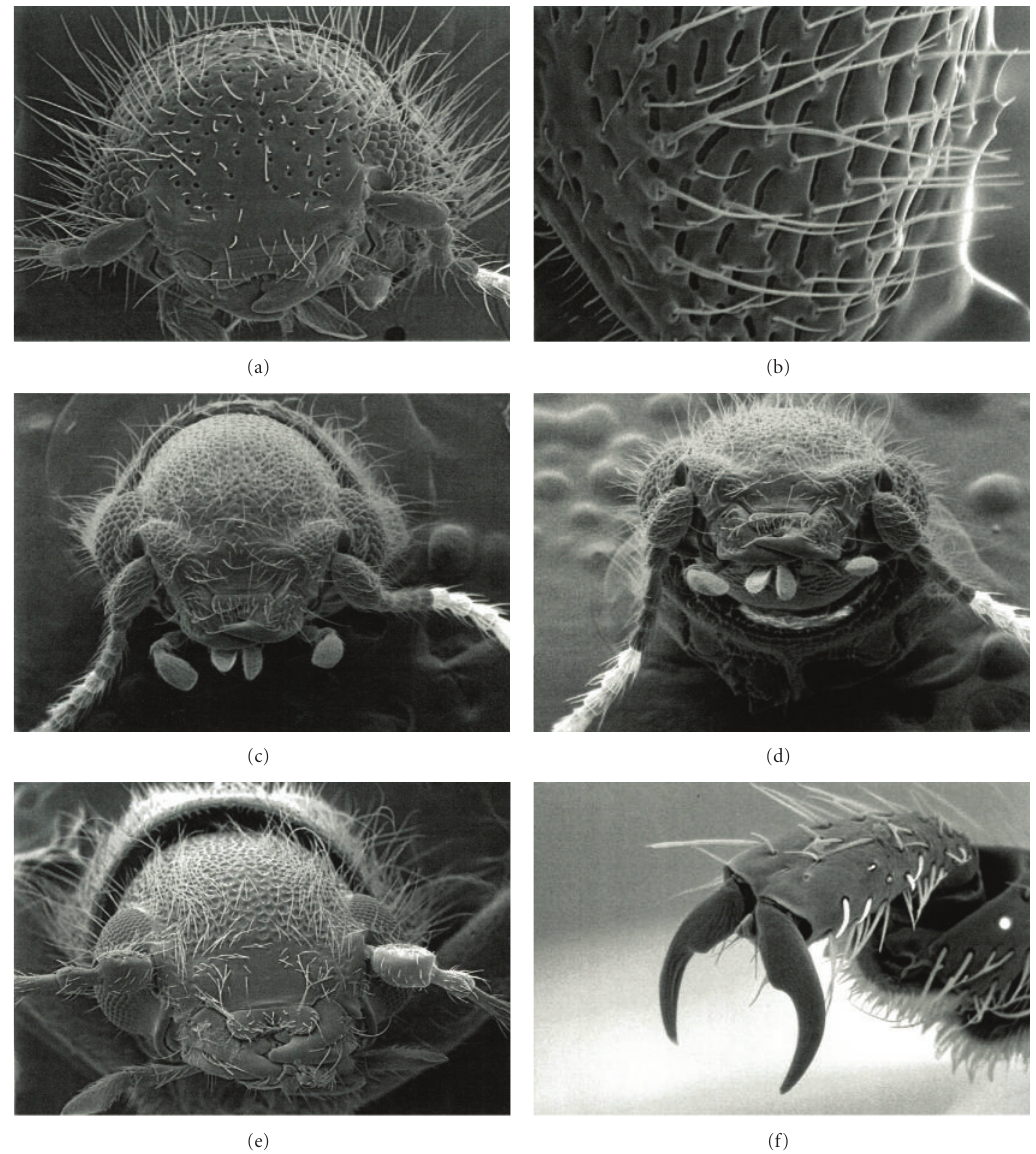
Figure 6: Various organs. (a, b) Curacavi dentatus ((a) head, (b) pronotal disc). (c, d) Pseudopilus okei ((c) head, (d) mouthparts). (e, f) Apteropilo chrysocome ((e) head, (f)